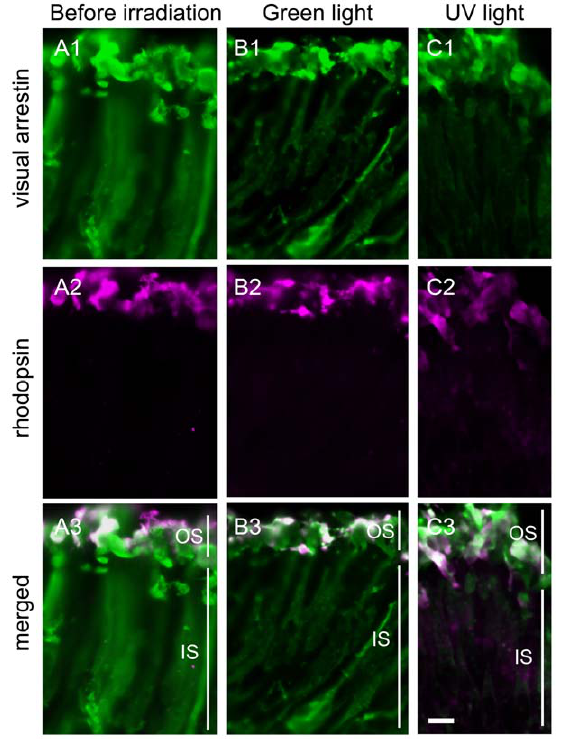
Figure 5. Light-regulated translocation of visual arrestin but not rhodopsin in the pineal photoreceptor cells. Rhodopsin- containing photoreceptor cells in the ventral region of isolated pineal organs before irradiation (A), after irradiation with green light for 6 hours (B) and after irradiation with UV light for 6 hours (C). Panels Ai- Ci and panels Aii–Cii show visual arrestin (green) and rhodopsin (magenta) immunoreactivities, respectively. Panels Aiii–Ciii are merged images of both immunoreactivities. The results indicate that visual arrestin translocated to the outer segments, but no granules containing rhodopsin and visual arrestin were observed. IS, inner segment; OS, outer segment. Scale bars, 10 m m.